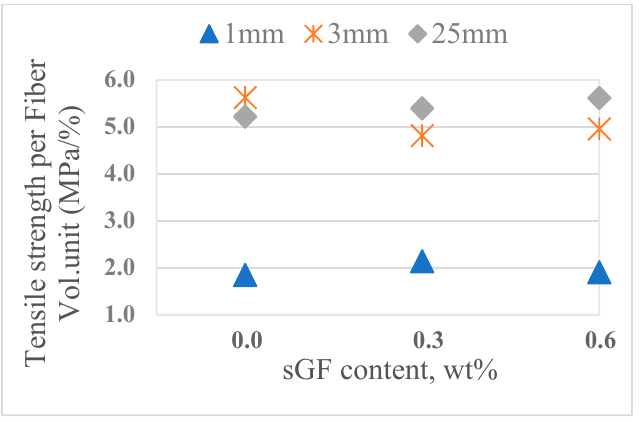
Figure 13. The tensile strength of composites with respect to CF length and added sGF content. Table 4. Mechanical performance of un-modified composites at different lengths of carbon fiber. Composite